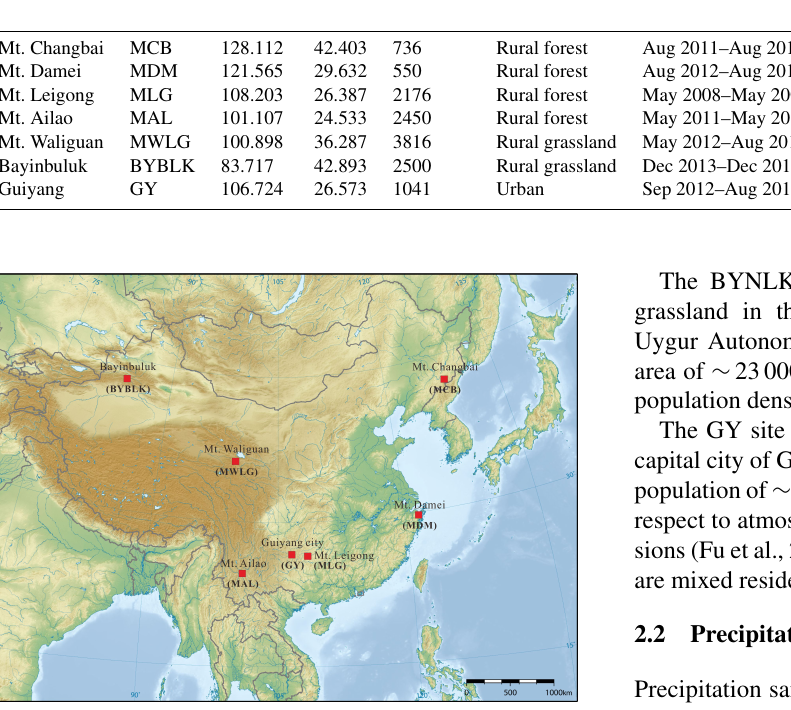
air transported by plain-to-mountain winds from southwest- ern China during